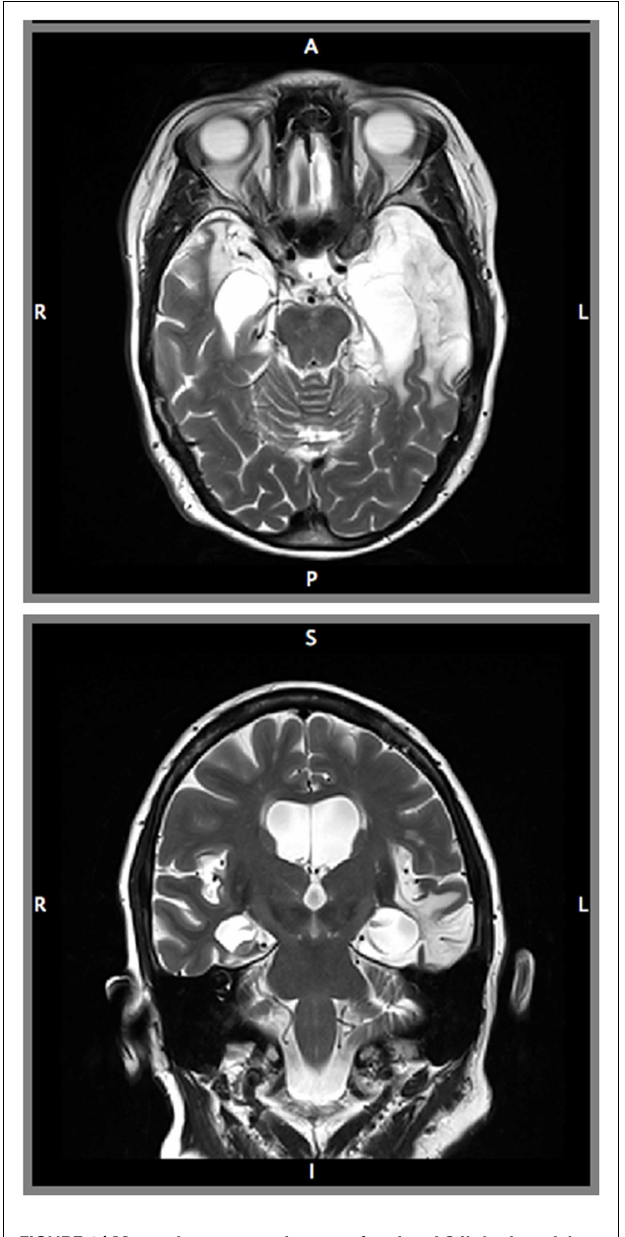
FIGURE 1 | Magnetic resonance images of patient LSJ’s brain: axial (Top) and coronal (Bottom) view .